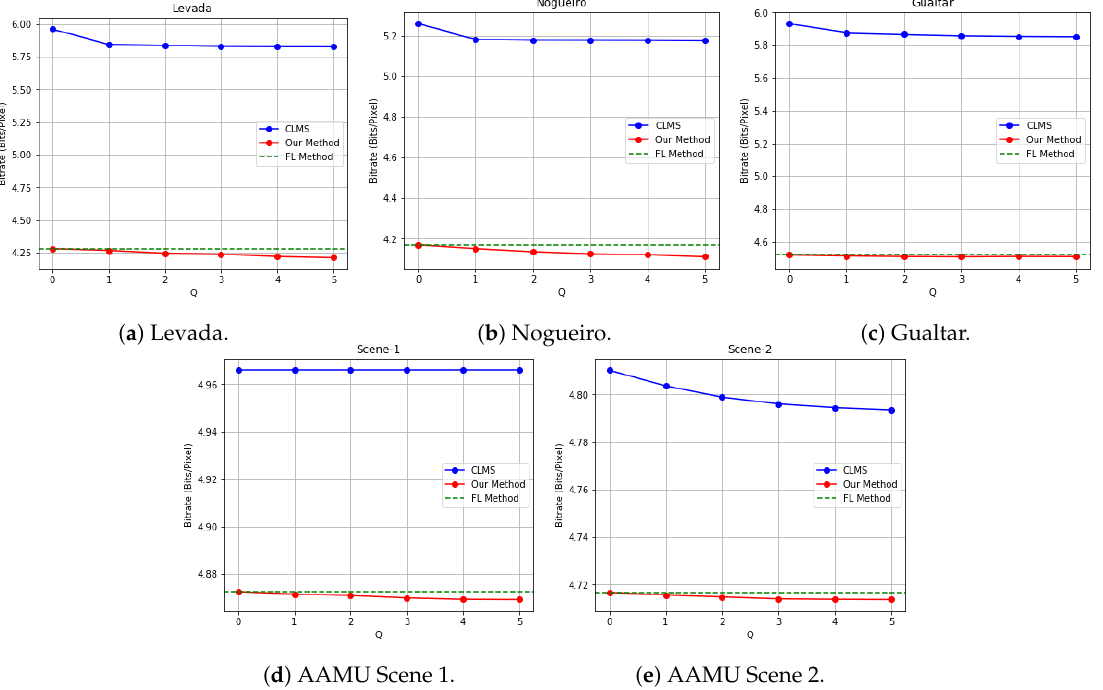
Figure 6. Bitrates comparison with CLMS and FL methods over five datasets for different Q when P =